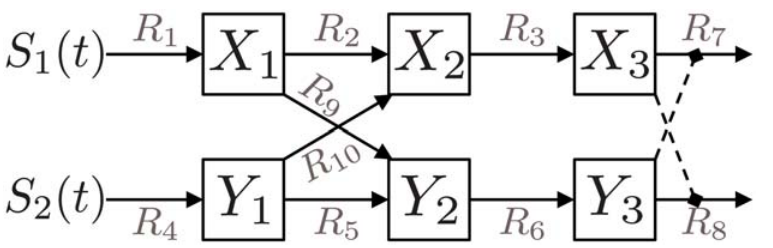
Fig 4. Signalling pathways with crosstalk. This figure shows two signalling pathways, with two crosstalk mechanisms. Functionality F 1 = { R 1 , R 2 , R 3 } is the X pathway; F 2 = { R 4 , R 5 , R 6 } is the Y pathway; the mutually inhibiting crosstalk F 3 = { R 7 , R 8 }; and the mutually excitatory crosstalk F 4 = { R 9 , R 10 }. Model adopted from